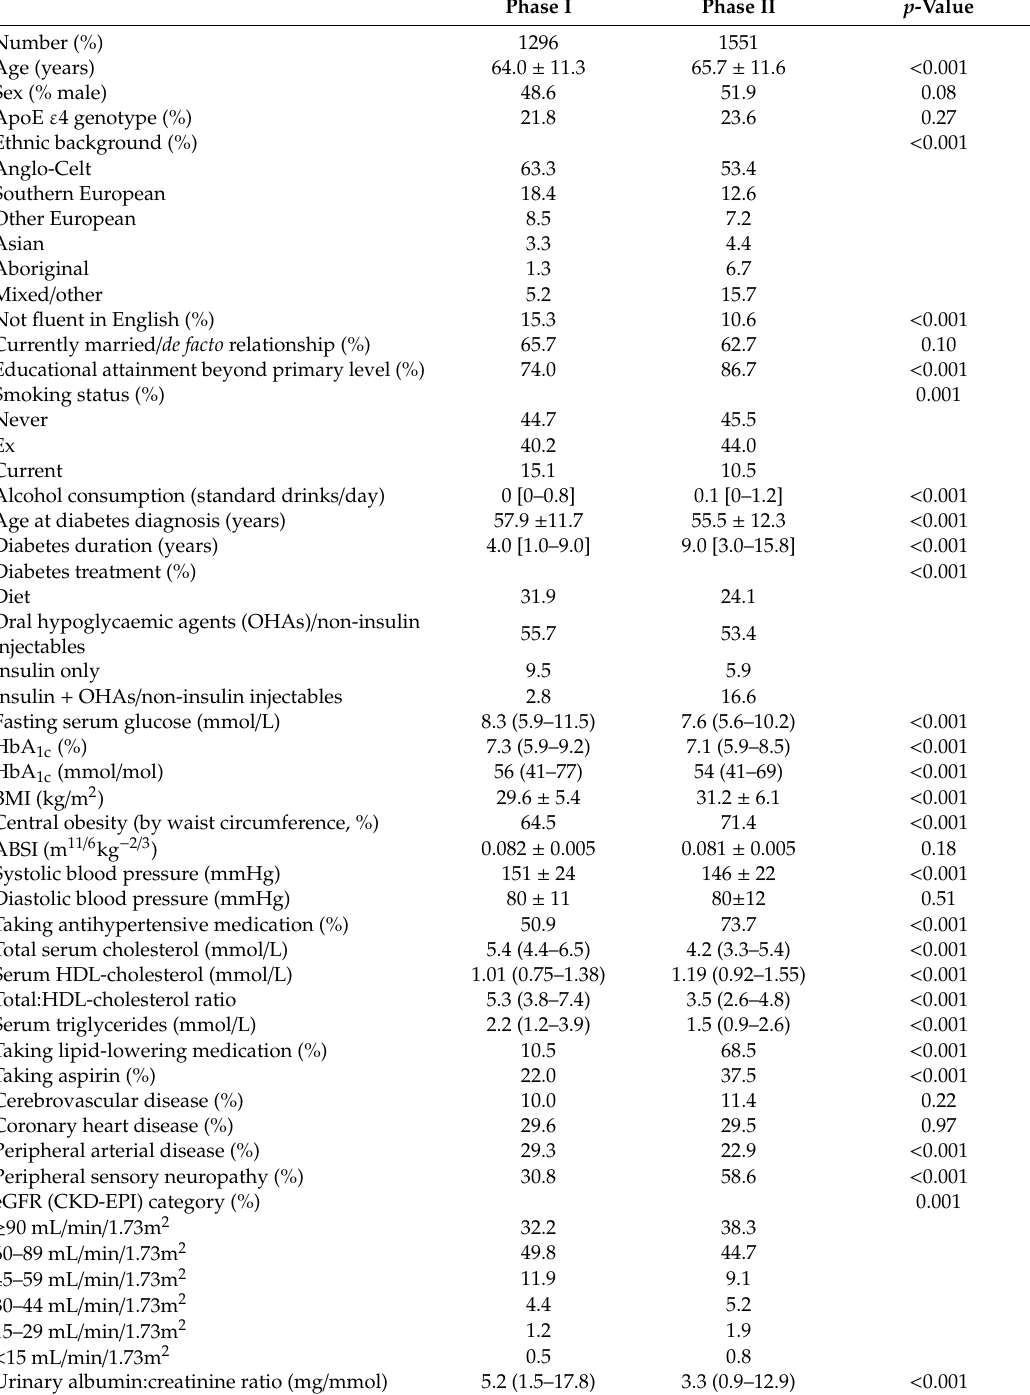
Table 1. Baseline characteristics of type 2 diabetes participants by Fremantle Diabetes Study Phase. Data are percentages, mean ± SD, geometric mean (SD range), or median (inter-quartile